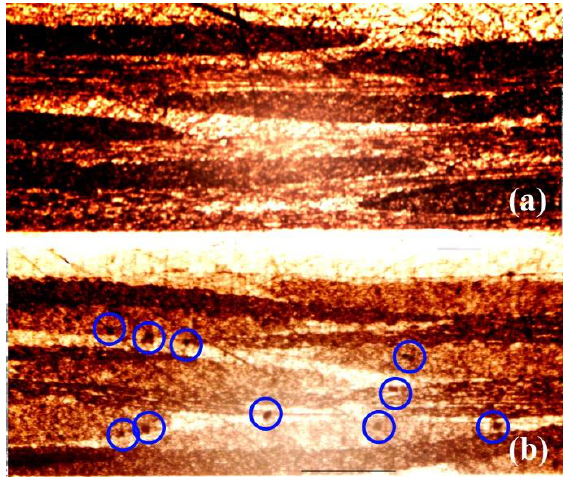
Figure 2. Micrographs of laminates: ( a ) autoclave processing, and ( b ) vacuum bag-only (VBO) processing. Blue circles show voids in the VBO laminate.